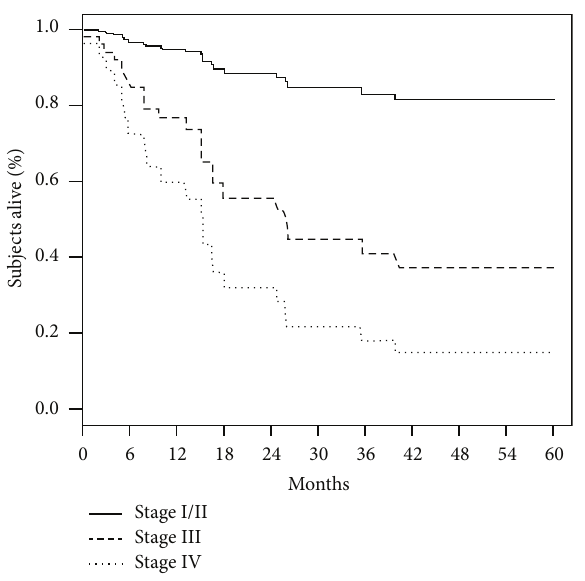
Figure 1: Age-adjusted survival by stage.